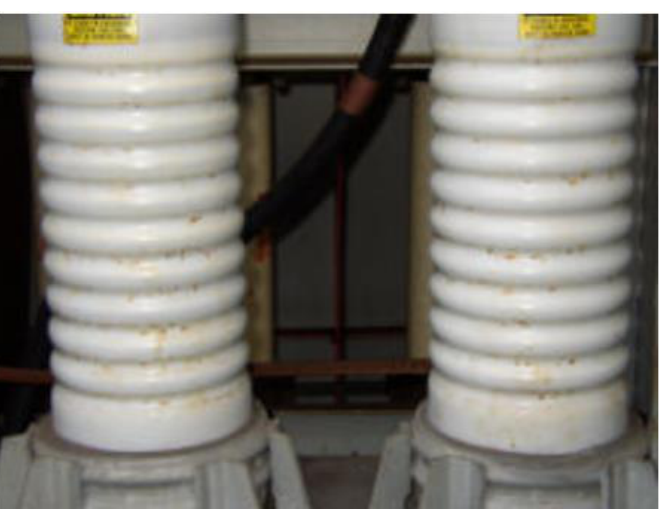
Figure 10. Contamination on ceramic bushing is caused by corona discharge [36].